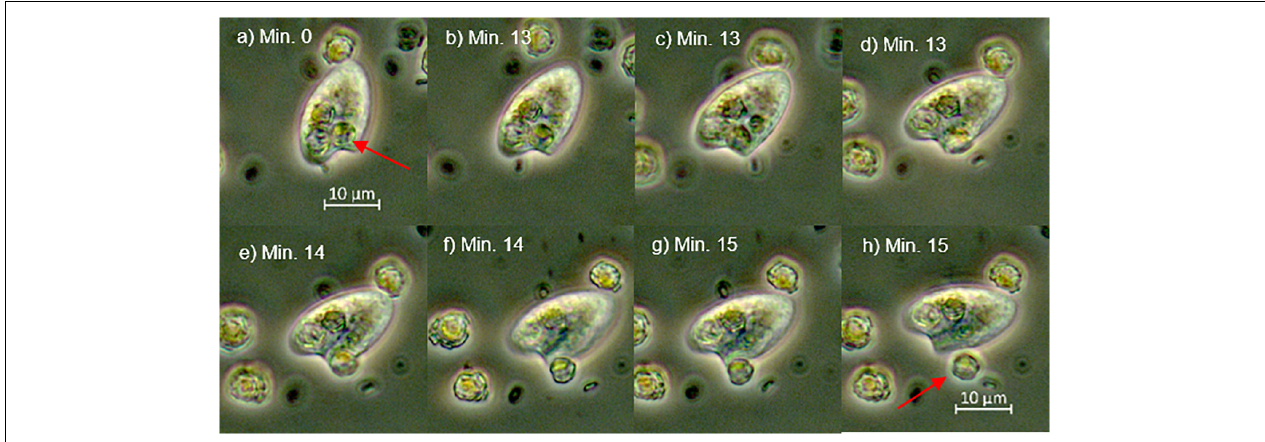
FIGURE 6 | This set of photos (a–h) show an O. marina specimen egesting a cell of E. huxleyi (red arrow). Prey egestion occurred within 3 min. Images were taken in a separate experiment where cells of E. huxleyi were not incubated for 36 h in the dark. The images vary slightly with respect to the focal plane.